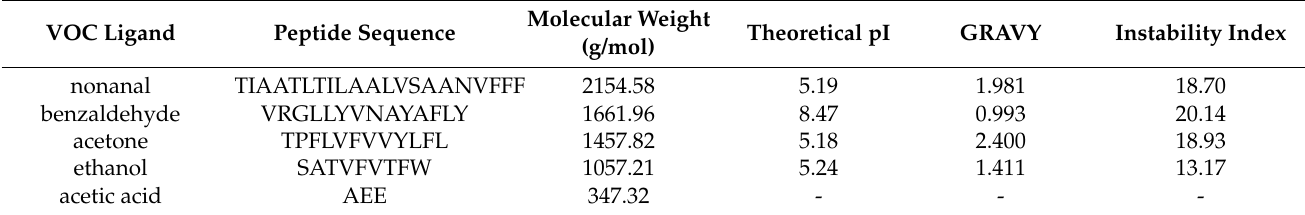
Table 2. The properties of the peptide derived from insect